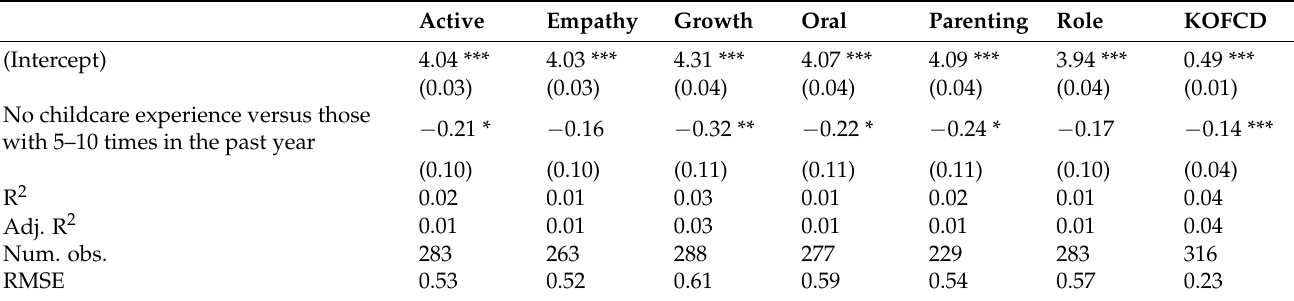
Table 9. Association between respondents with no childcare experience versus those with a moderate amount of childcare experience and the APKAS responses by